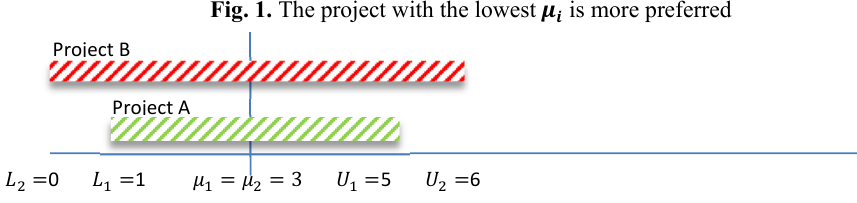
Fig. 1. The project with the lowest 𝝁